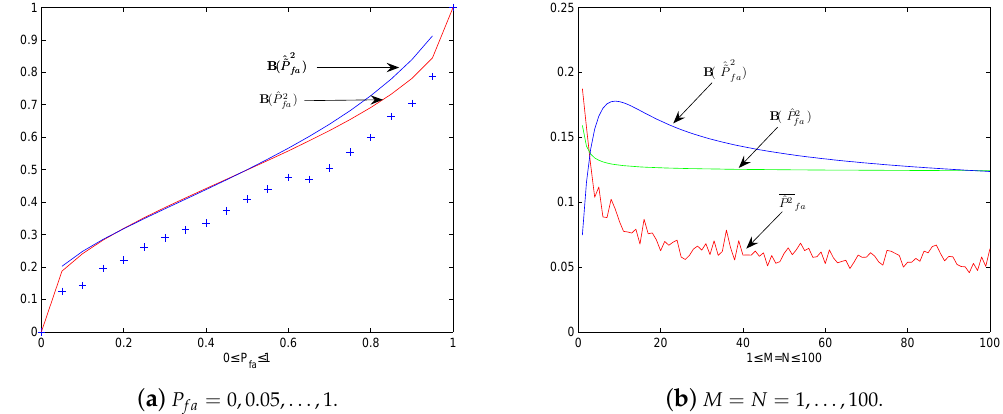
and E ˆ˜ P 2 and their upper bounds. ( a ) The plot of ˆ P 2 fa Figure 4. The plot of approximation of E ˆ P 2 fa fa ) and B ( ˆ˜ P 2 ) vs. P = 0,0.05, . . . ,1. ( b ) The plot of ˆ P 2 by ’+’, B ( ˆ P 2 fa fa fa M = N = 1, . . .